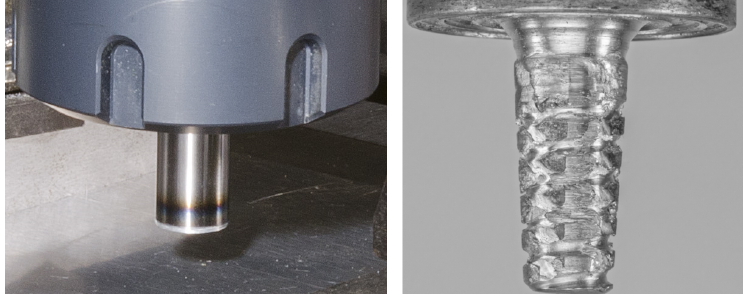
Figure 6. Aluminum adhering to tools after friction experiment ( left ) and real FS welding pro- cess ( right ).